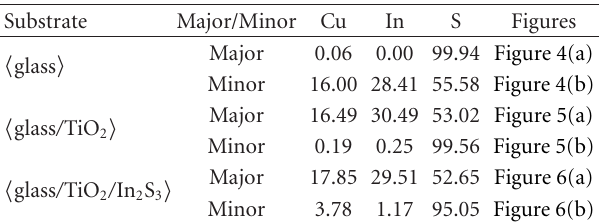
Table 1: The atomic ratios of Cu-In-S analyzed by TEM-EDX. Each location is indicated by the relevant figure